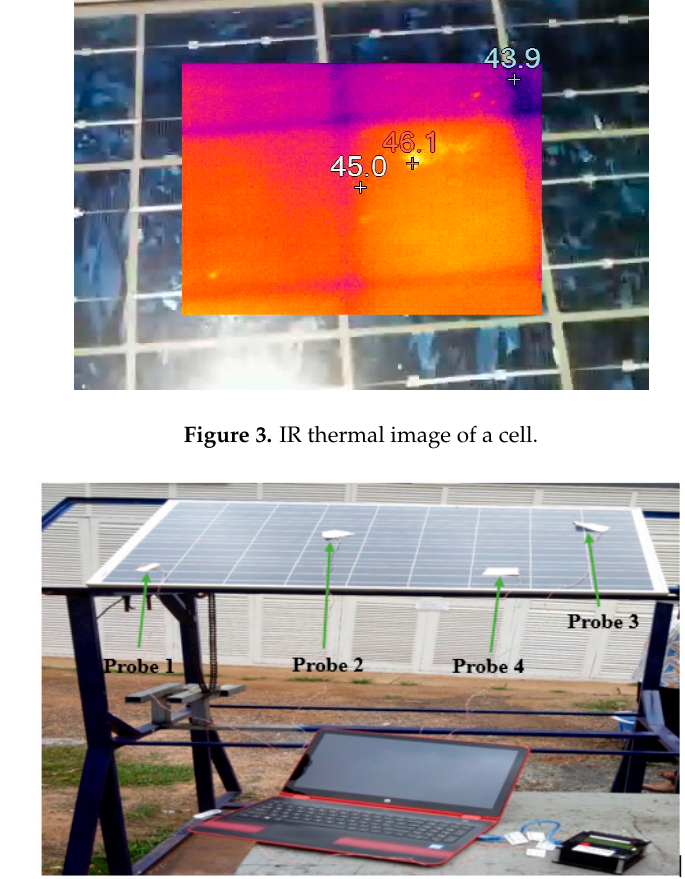
Figure 4. Setup for comparison of IR imager and temperature probes.